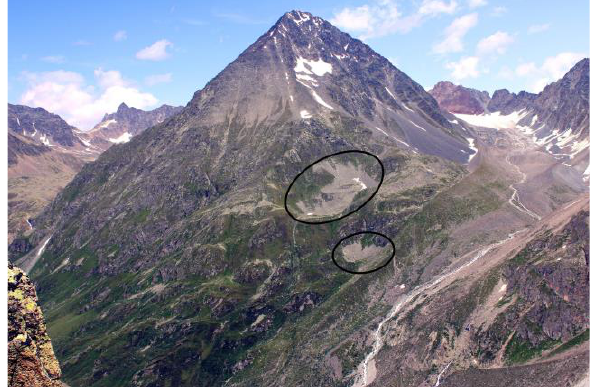
Figure 2. Overall workflow of the study.